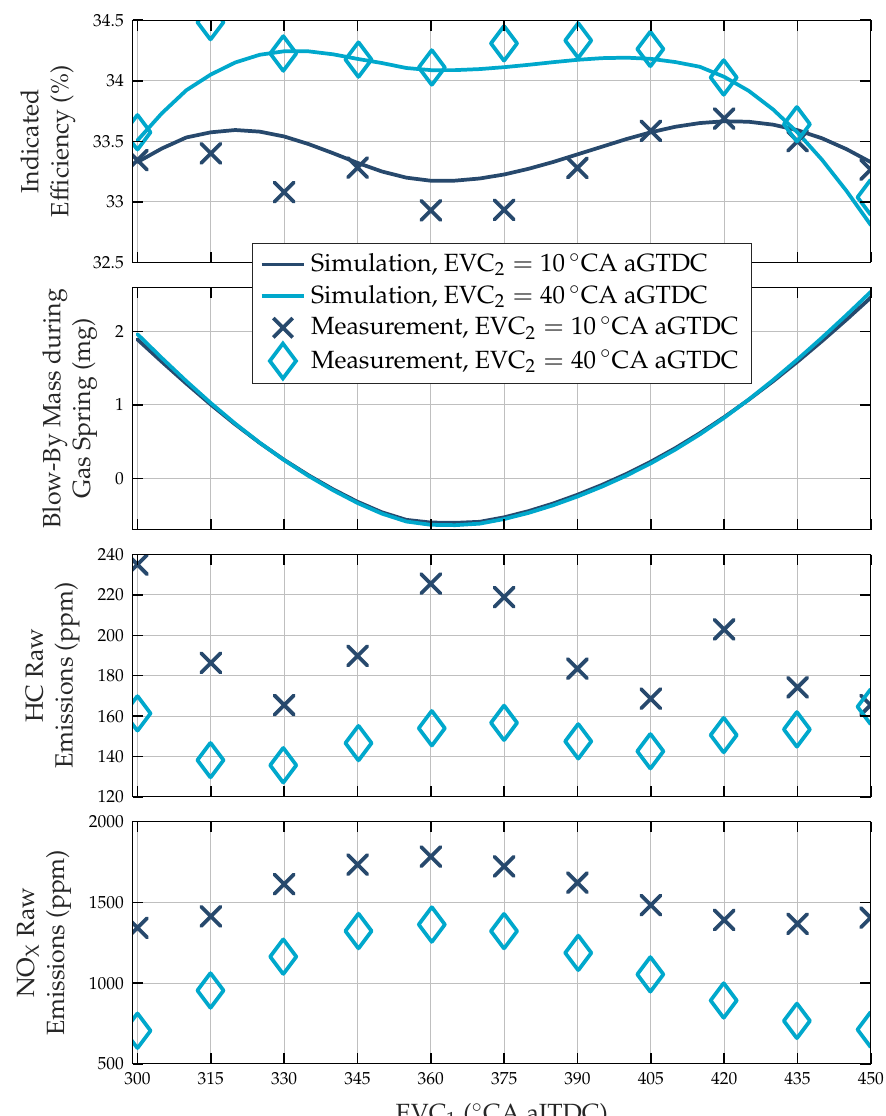
Figure 5. Comparison of simulated and experimental results of valve timing grid searches for a 12-stroke